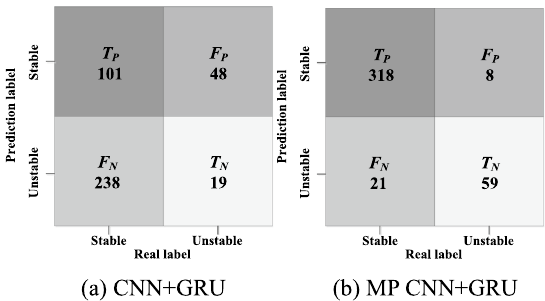
Fig. 8 TSA analysis results on the IEEE 145-bus system